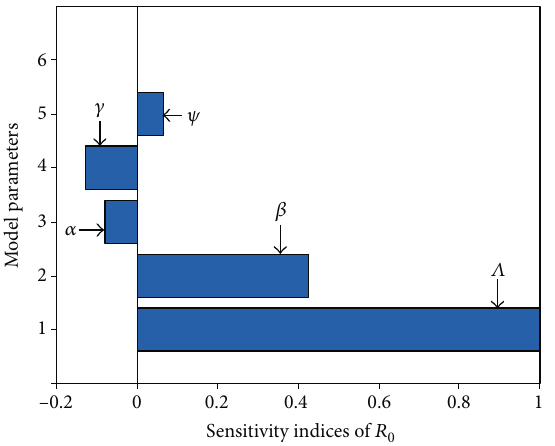
Figure 9: The numerical result of sensitivity analysis.